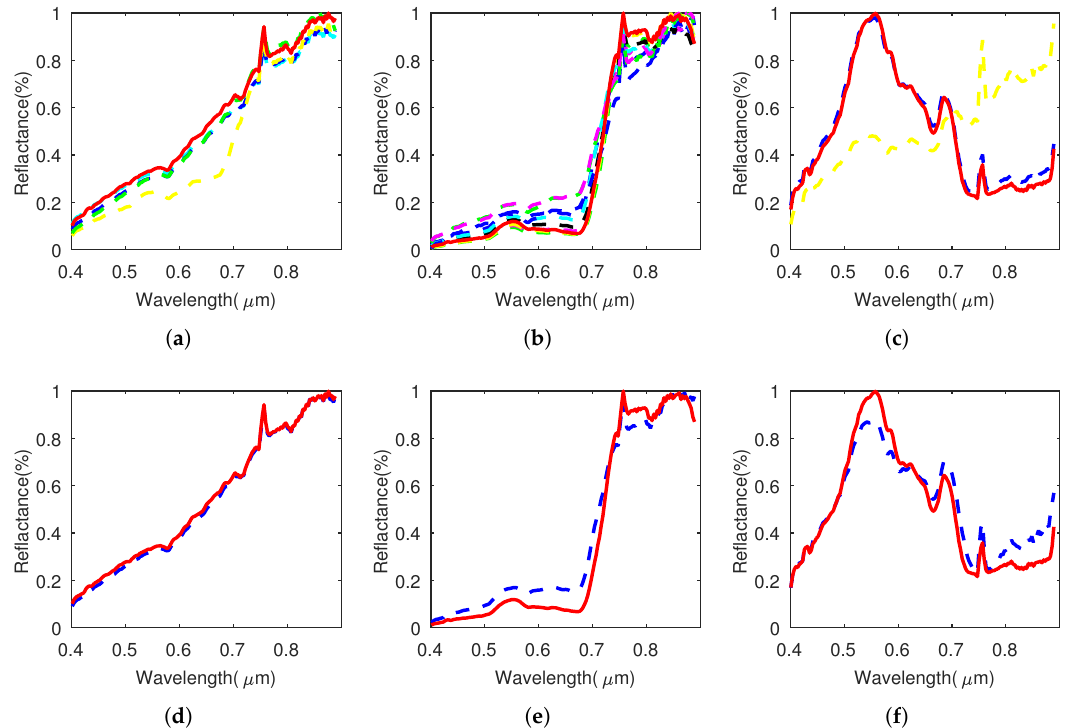
Figure 3. Comparison between the reference endmembers (red solid line) and the atoms (dotted line) of the learned dictionaries given by our DNDF-L2 on Samson . ( a – c ) plots the reference endmembers and the atoms of the dictionary learned in the first layer factorization, and ( d – f ) compares the reference endmembers and the atoms of the dictionary of second layer. ( a ) Soil ; ( b ) Tree ; ( c ) Water ; ( d ) Soil ; ( e ) Tree ; ( f ) Water